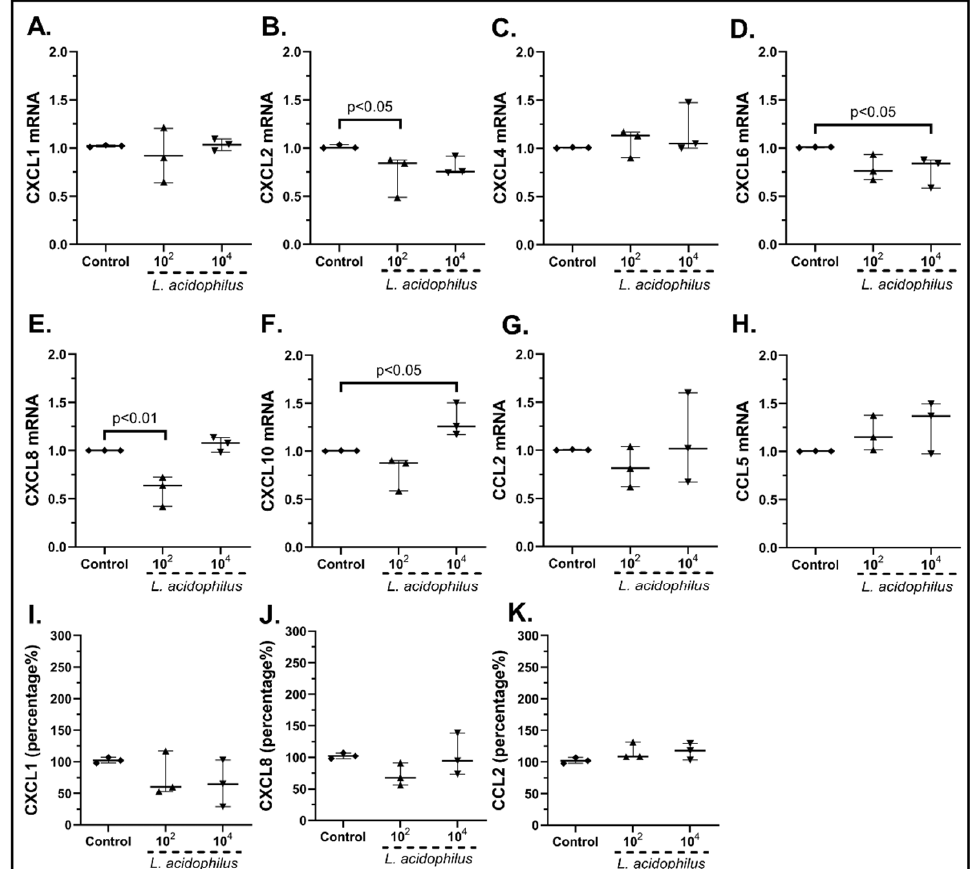
Figure 6. cSEMF mRNA expression of CXCL1 ( A ), CXCL2 ( B ), CXCL4 ( C ), CXCL6 ( D ), CXCL8 ( E ), CXCL10 ( F ), CCL2 ( G ) and CCL5 ( H ) and protein levels of CXCL1 ( I ), CXCL8 ( J ) and CCL2 ( K ) after stimulation with Lactobacillus acidophilus. Results are presented as median with interquartile range. N = 3.